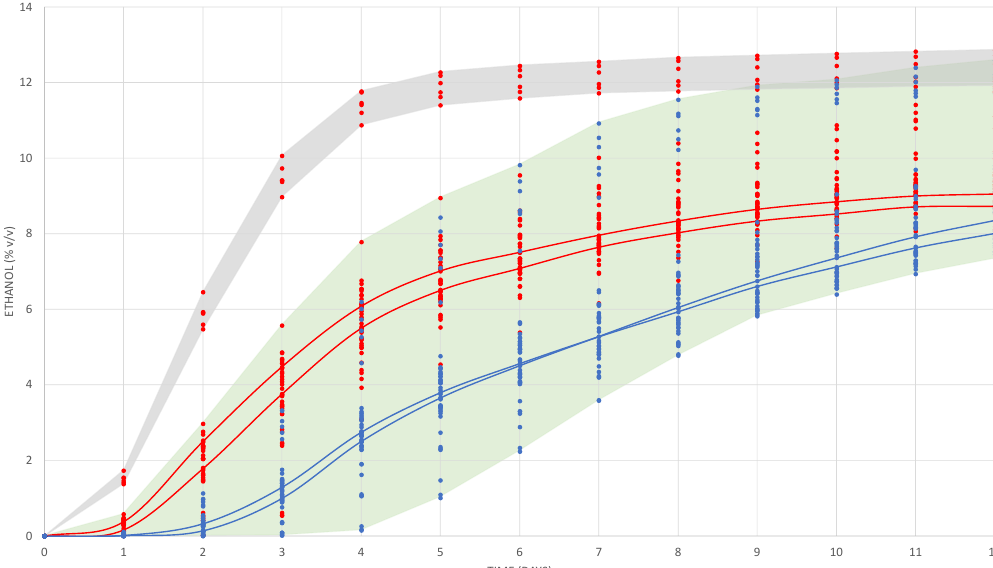
Figure 1. Evolution of the alcoholic content produced during fermentation by the seven yeasts and measured by weigh losses in the micro-fermenters for the four treatments (17 and 27 °C, 25 and 75 mg/L of total SO 2 ). The blue dots represent fermentations at 17 °C and red dots at 27 °C. Continuous lines represent the average for L. thermotolerans strain L3.1; blue lines at 17 °C (25 and 75 in SO 2 ) and red lines 27 °C (25 and 75 in SO 2 ). Grey shadow contents the dots for S. cerevisiae at 27 °C, and green shadow includes all fermentations with all strains of L. thermotolerans plus S. cerevisiae at 17 °C.